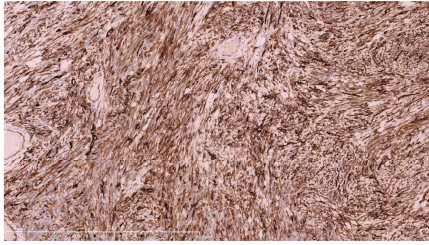
Figure 3: The spindle cells show strong and diffuse positivity for CD34. × 100 magnification.